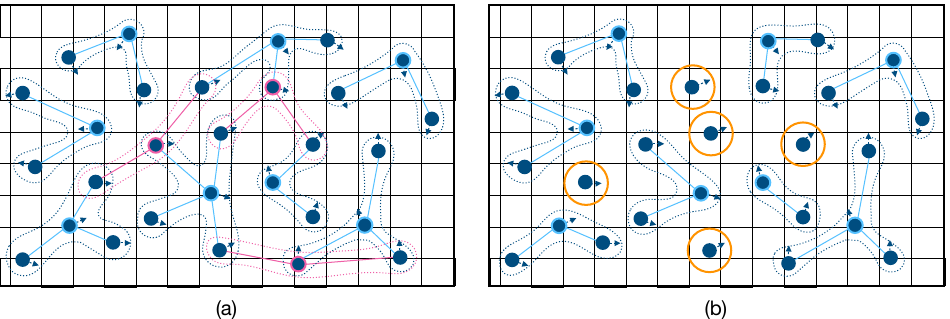
Figure 5. The consensus problem in cluster formation. ( a ) Some agents that view themselves as Figure 9: The consensus problem in cluster formation. (a) Some agents that view themselves as members of blue clusters appear to other agents as heads of purple clusters. (b) Agents attempting to members of blue clusters appear to other agents as heads of purple clusters. ( b ) Agents attempting to form purple clusters become orphans. form purple clusters become orphans (circled in orange).